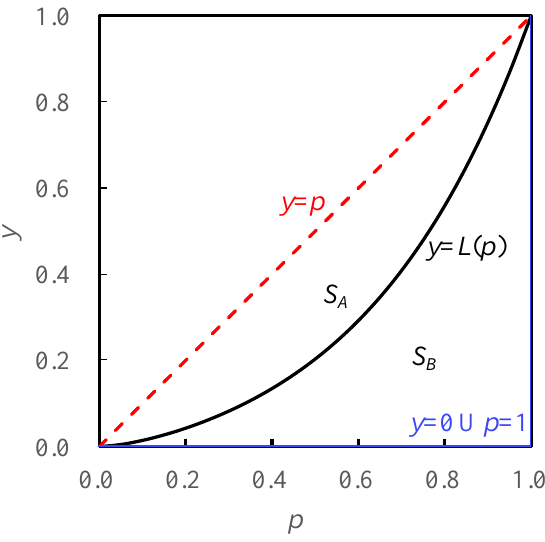
Figure 1. Sketch of the Lorenz curve showing the cumulative share of income or another variable under consideration ( y ∈ [0, 1]) from different sections of population or another variable ( p ∈ [0, 1]). The curving fitting method fits the data with functions that meet the requirements of the Lorenz curve, i.e., non-negativity, monotonicity, and convexity [12,13]. However, an appropriate function is usually selected from a group of possible functions for specified data, and the selected function is generally not flexible enough to depict the complex variation of actual data globally [13]. Moreover, the fitted Lorenz curves can only represent the global trend and generally do not pass through all the data points, which is a common characteristic of the curve fitting